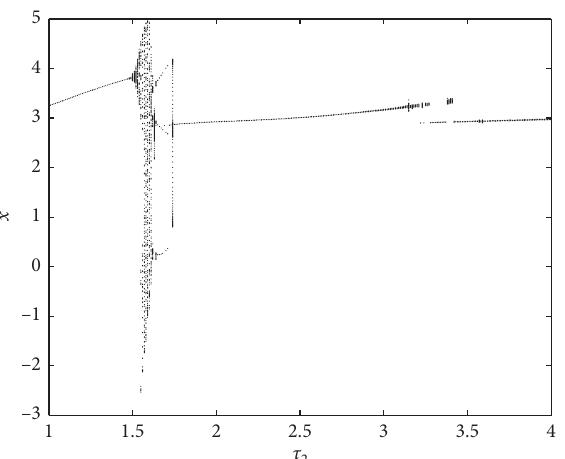
Figure 5: Bifurcation diagram of system (3a)–(3c) with initial value ( 0 . 1 , 2 , 0 . 1 ) and τ